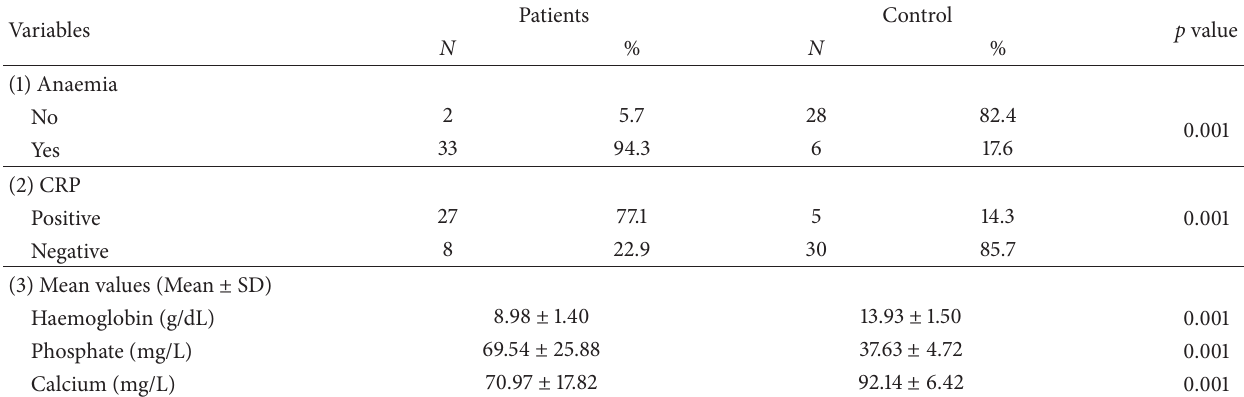
Table 1: Comparison of specific cardiovascular disease risk factors between haemodialysed patients and healthy controls.